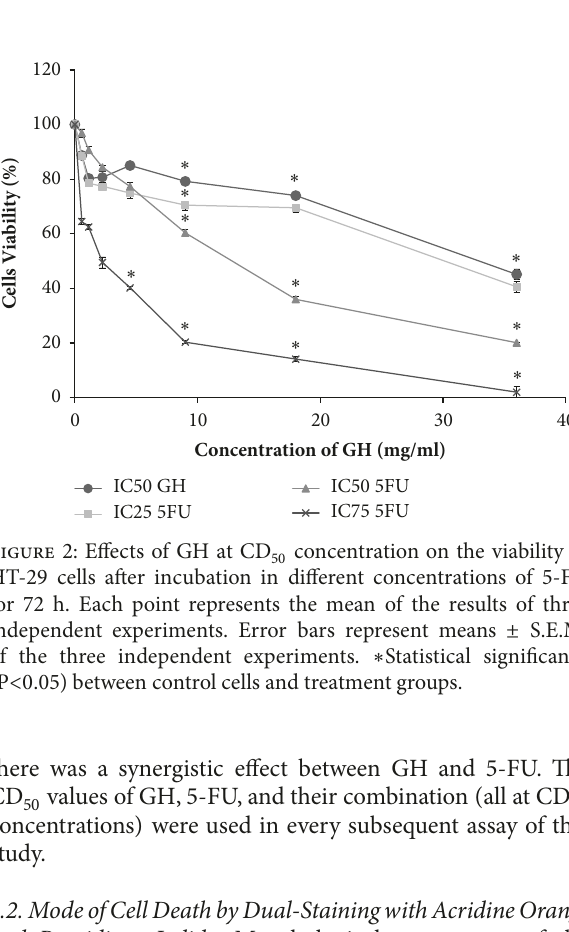
minutes in a dark environment. After that, the cells were then analysed in CytoFLEX (Beckman Coulter, USA) using the CytExpert software.